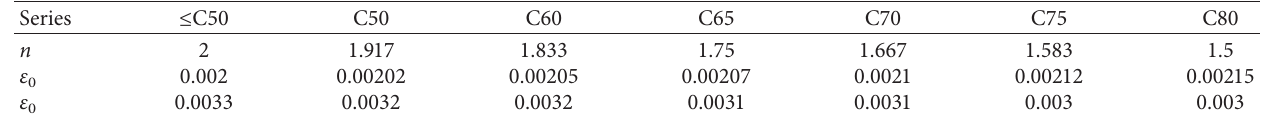
Table 5: The values of n , ε